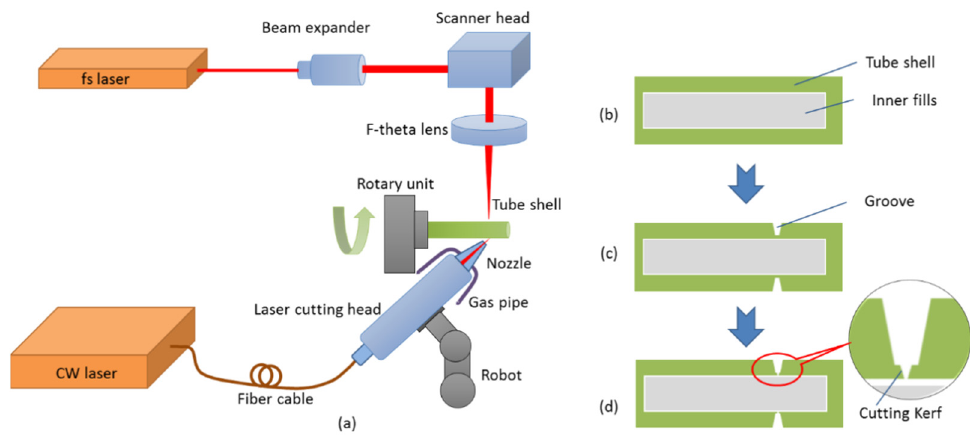
Figure 1. Configuration of the dual laser beam asynchronous dissection process: ( a ) schematic diagram of the cutting system, ( b ) cross-sectional view of the tube shell, ( c ) the tapered groove created by the fiber laser, and ( d ) the cutting kerf after the femtosecond laser completed cutting.